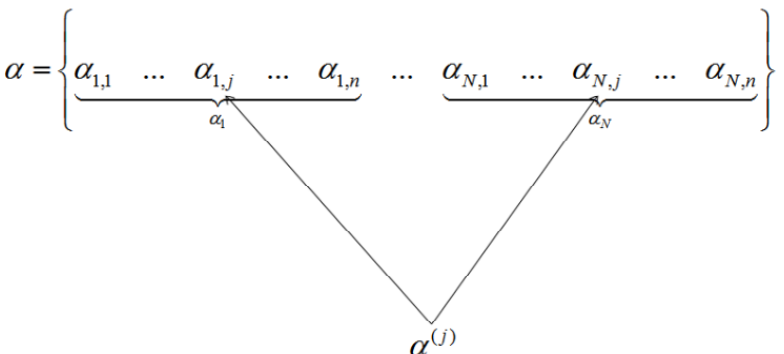
Figure 2. Grouping according to